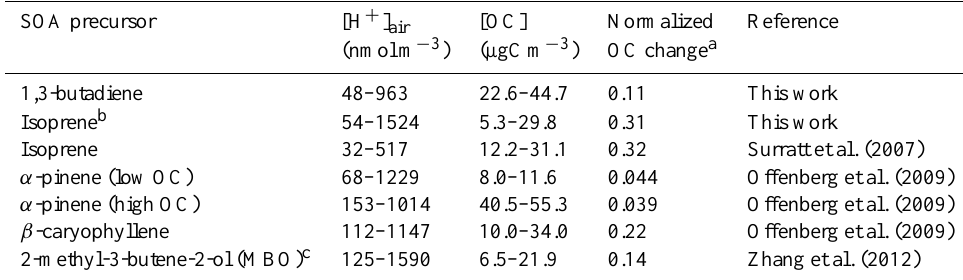
Table 3. Summary of the normalized yields for sulfate acidity effect for precursor hydrocarbons studied to date. SOA formed in the presence of NO x at 30% relative humidity, except where indicated.